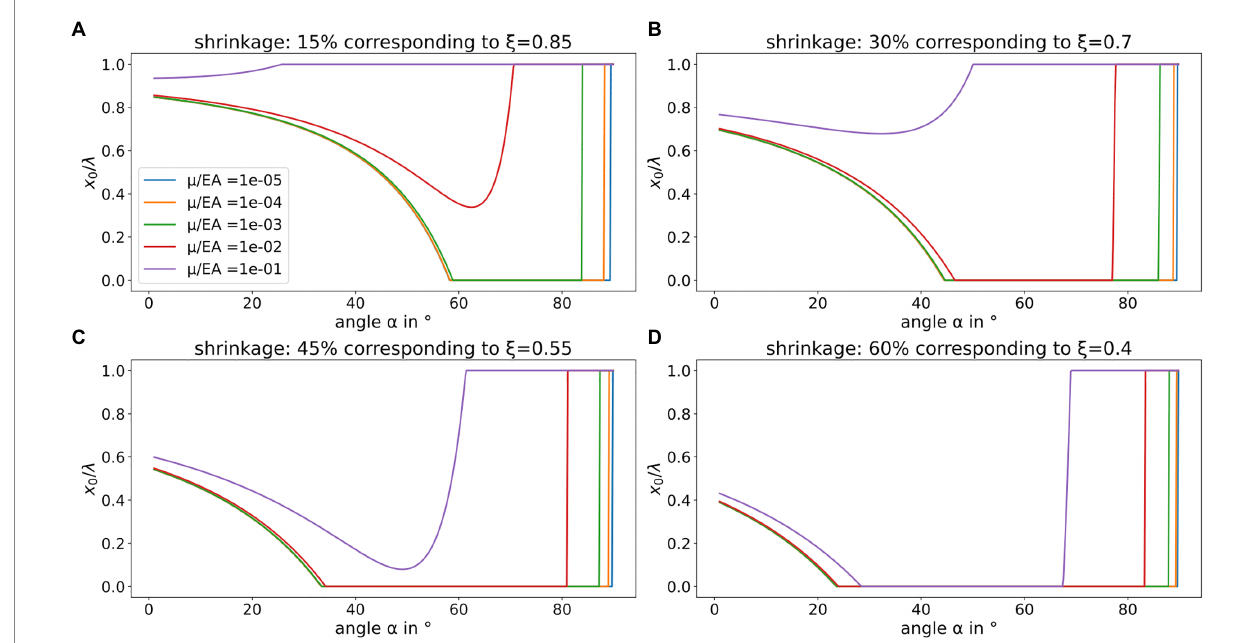
FIGURE 3 Adhesive contact in dependence on shrinkage, surface geometry, adhesive interaction, and fiber stiffness. A ratio x 0 / λ = 1 means full adhesive contact of the fiber and the surface geometry given, whereas x 0 / λ = 0 means that the fiber only touches the tips of the triangular surface geometry. The individual panels show the behavior for different values of shrinkage: (A) 15% shrinkage, (B) 30% shrinkage, (C) 45% shrinkage, and (D) 60% shrinkage. The ratio μ / EA ranging from 10 − 5 to 10 − 1 is identically color-coded in every panel. To be physically meaningful, the ratio x 0 / λ has to be clipped between 0 and